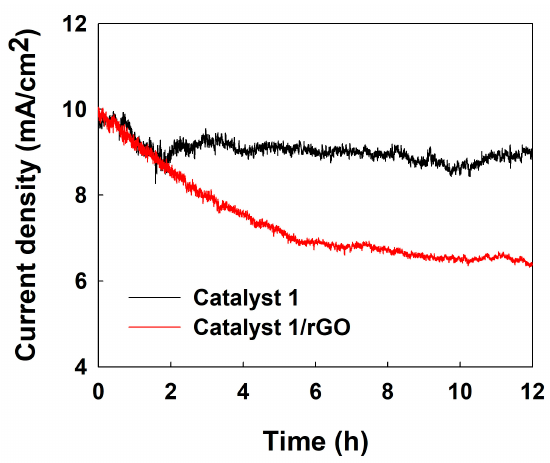
Figure 3. Chronoamperograms of the catalyst 1 /rGO composite- (red) and catalyst 1 -modified (black) GCEs during the OER. The electrolyte solution was O 2 -saturated 0.1 M KOH. The rotation rate of RDE was 1600 rpm.